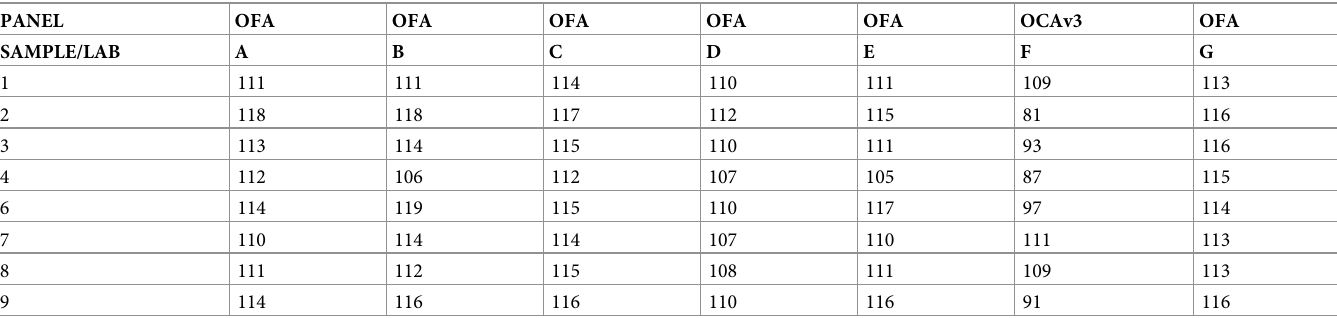
Table 7. Phase 2 DNA read length values. PANEL